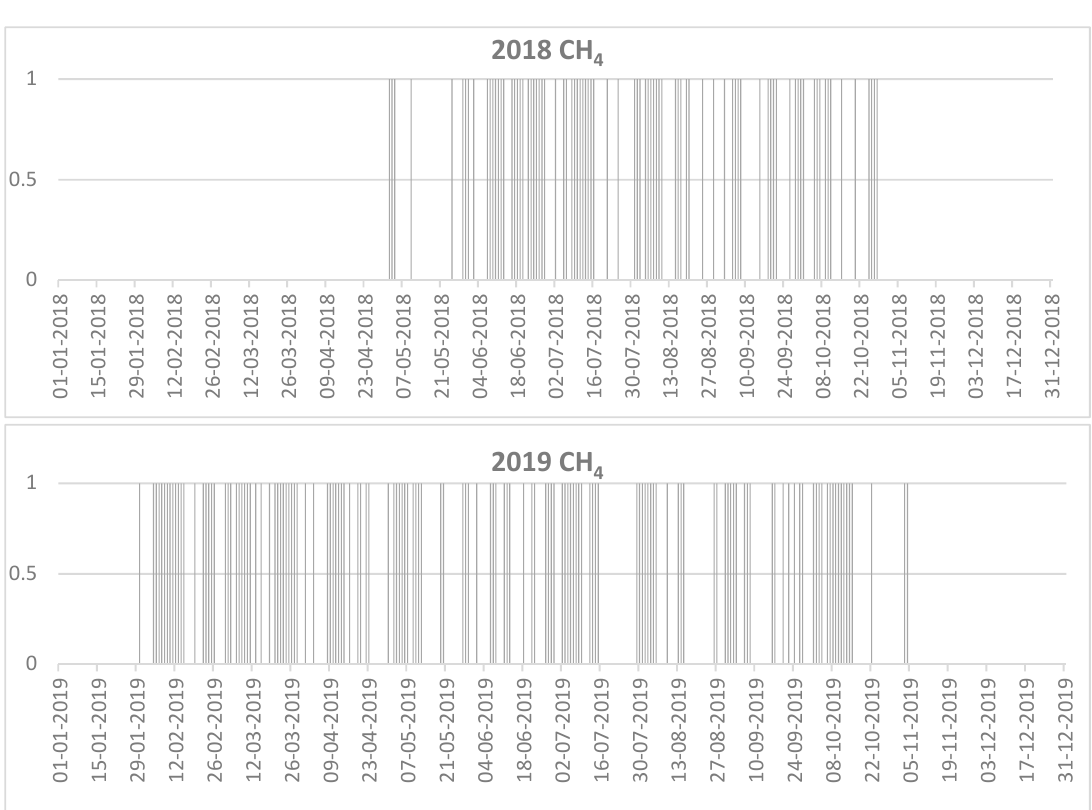
Figure 5. Number of registered events of high methane emissions for the period May 2018– December 2022 on a monthly basis in the Kemerovo region, Russia. Data used—Sentinel-5P. Figure 6 shows the individual days with high methane emissions in the study area. A cluster of pixels exceeding 3 σ is required to record an emission event. For many of the days in the study time interval from May 2018 to December 2022, several clusters with high methane emission values were detected simultaneously on the same day. This is an indication of the presence of multiple super-emitters in the Kemerovo region.